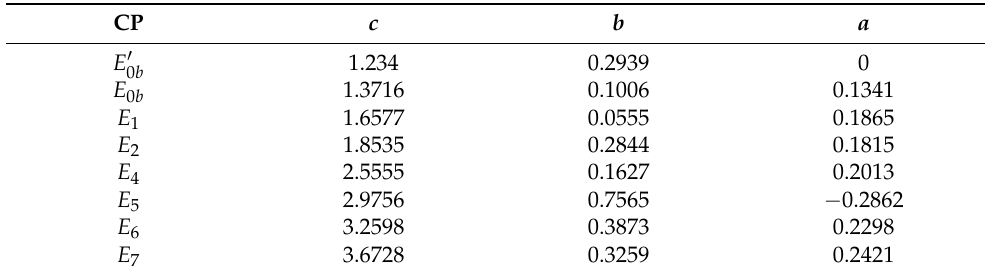
Table 4. As Table 3, for the armchair direction.